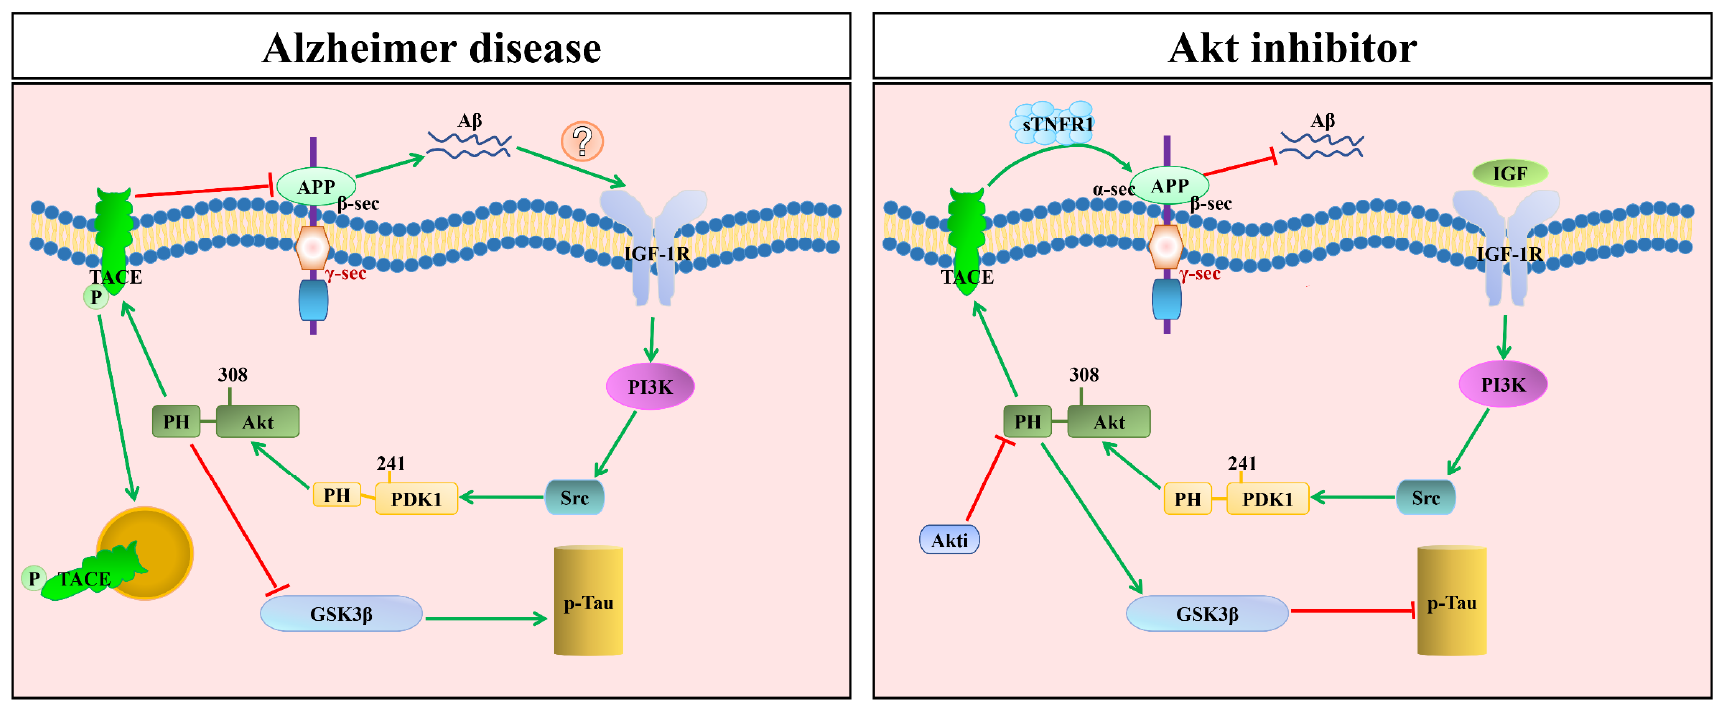
Figure 5. In Alzheimer’s disease, the activity of APP γ-secretase could lead to APP cleavage and generate Aβ, increasing the activation of PI3K and the phosphorylation of PDK1 at Ser241 and Akt at Thr308 and Ser473, then phosphorylating TACE. This process induces the internalization of TACE in the caveolae, thereby reducing the TACE-mediated production of sTNFR1. If Akt inhibitor is used at the Thr308 site, this reduces the phosphorylation of TACE, which preserves all the TACE at the membrane, increases the TACE-mediated production of sTNFR1, and decreases the accumulation of Aβ.